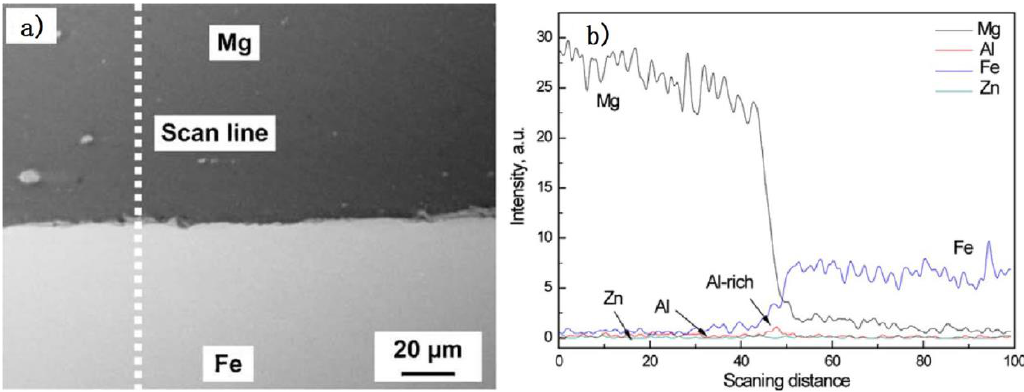
Figure 4. FSW Mg/Zn coated steel process [17] ( a , b ) SEM micrographs near Mg/steel interface and EDS analysis results along the scan line in ( a ).